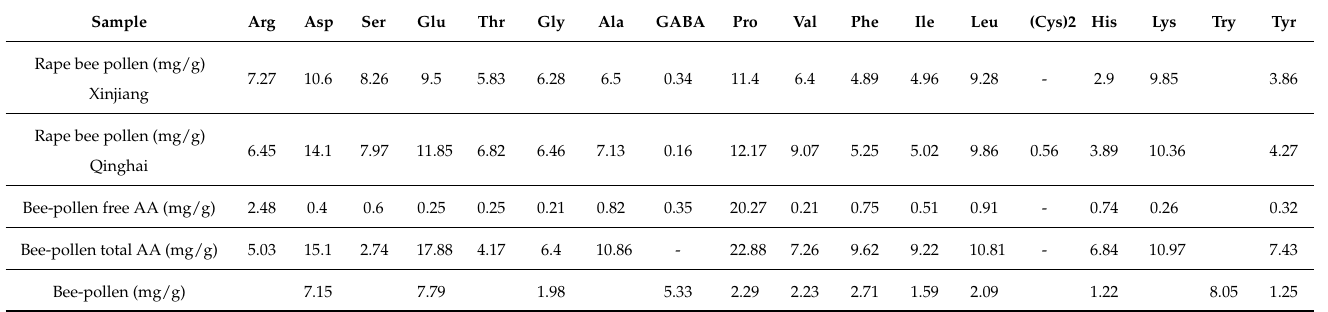
Table 2. Reported amino acids levels from bee pollen and bee bread